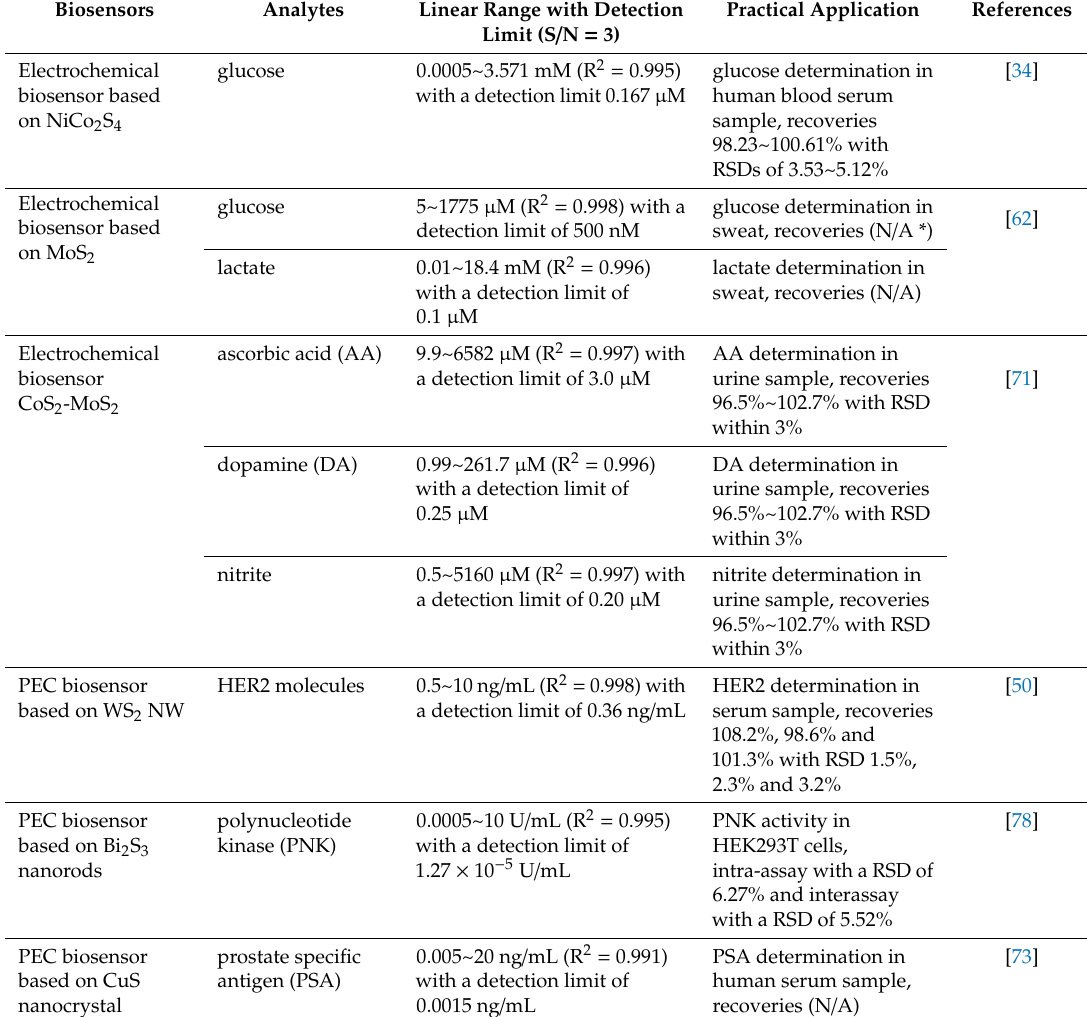
Table 2. Properties of biosensors based on metal sulfide nanomaterials listed